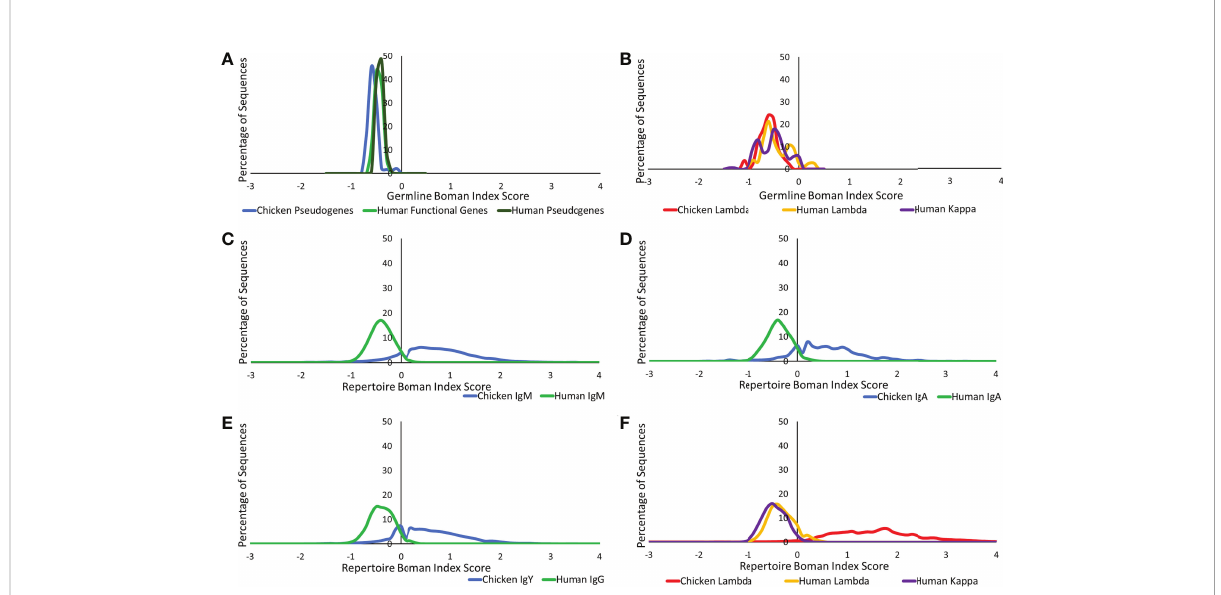
FIGURE 9 Protein binding potential (Boman index) comparison of germline variable genes between (A) chicken pseudogenes, human functional genes, and human pseudogenes at the heavy chain loci and (B) chicken pseudogenes, human lambda functional genes, and human kappa functional genes at the light chain loci. Comparison of the protein binding potential between repertoire sequences shows (C) chicken IgM against human IgM, (D) chicken IgA against human IgA, (E) chicken IgY against human IgG, and (F) chicken lambda light chain sequences against human lambda light chain sequences and human kappa light chain sequences. Boman index score calculated by BRepertoire online immunoglobulin repertoire analysis tool using the CDR3 region amino acid